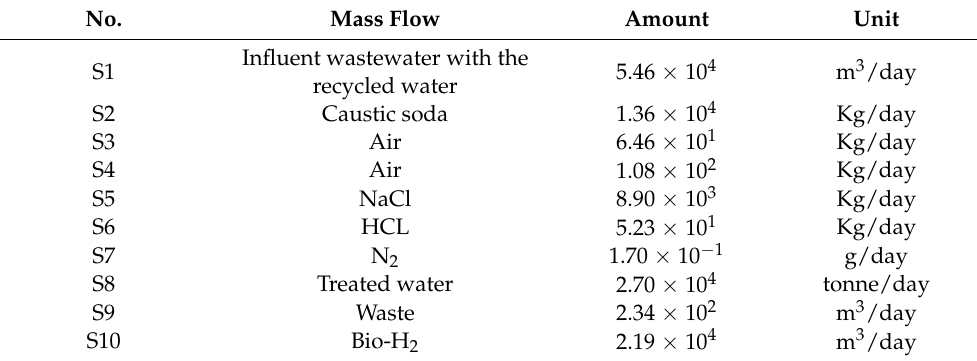
Table 5. The mass flow for the system